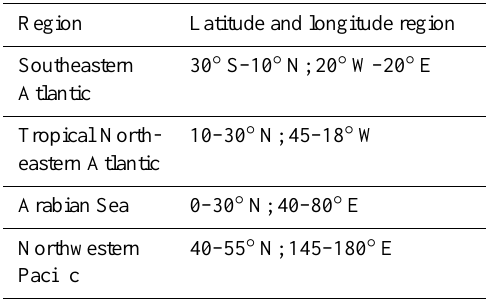
Table 1. Geo-locations of four active ACA